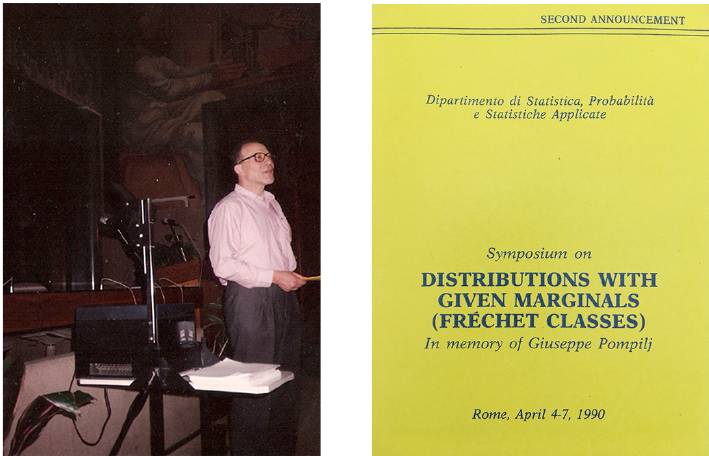
Figure 3: Giorgio Dall’Aglio (left) in 1990 during the symposium held in Rome on “Distributions with Given Marginals (Fréchet classes)”. This picture has been taken by Abe Sklar. The poster announcing the symposium is shown on the right.